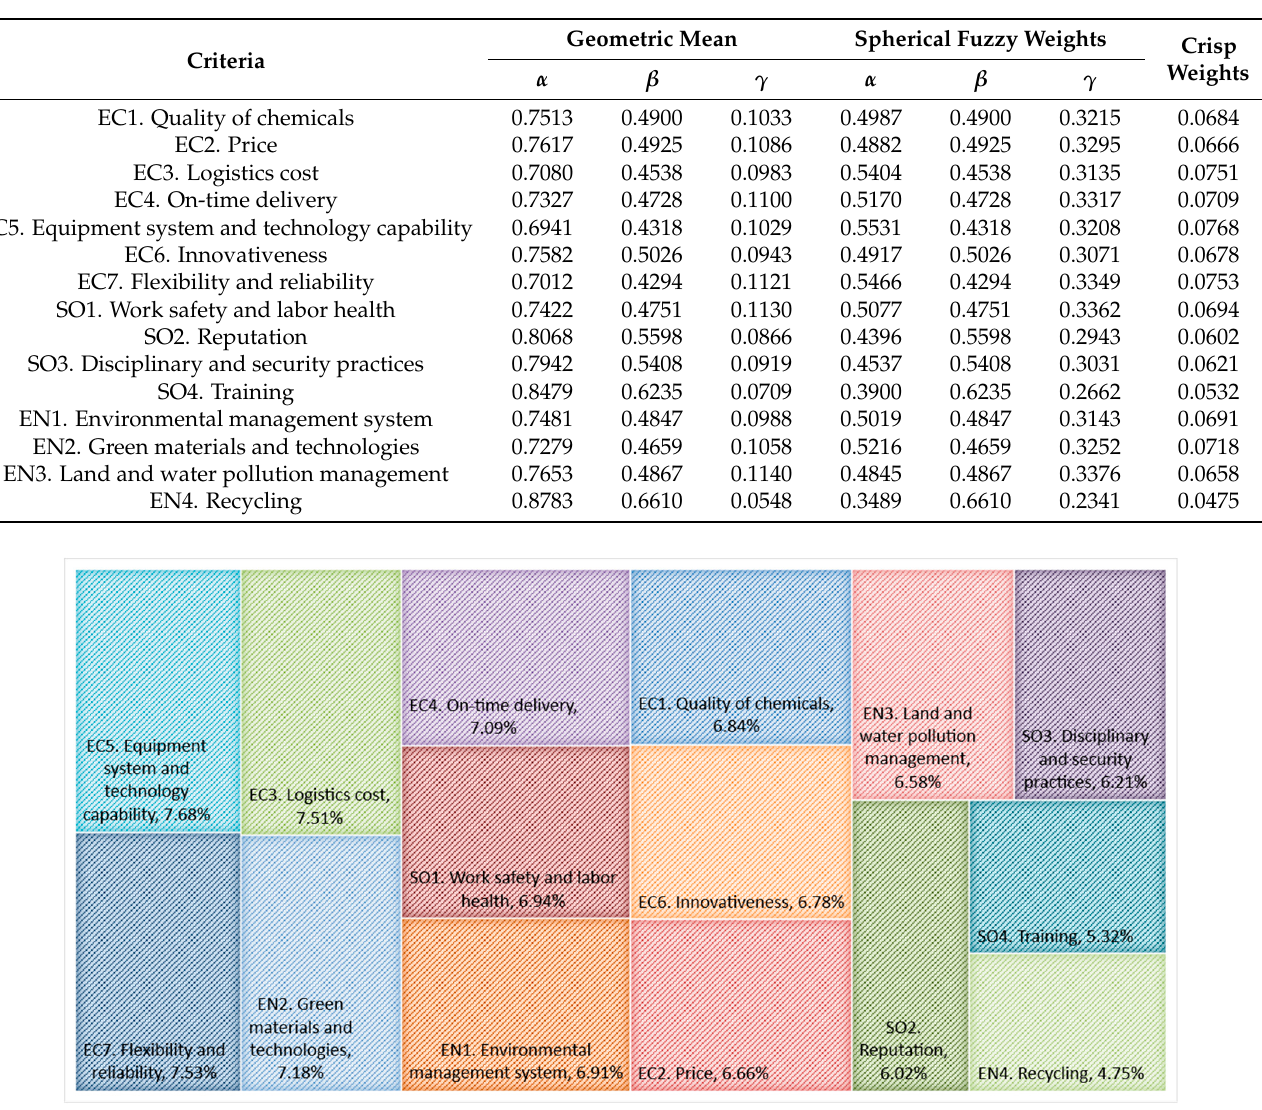
Table 11. Spherical fuzzy weights and crisp weights of 15 criteria of SF-AHP.